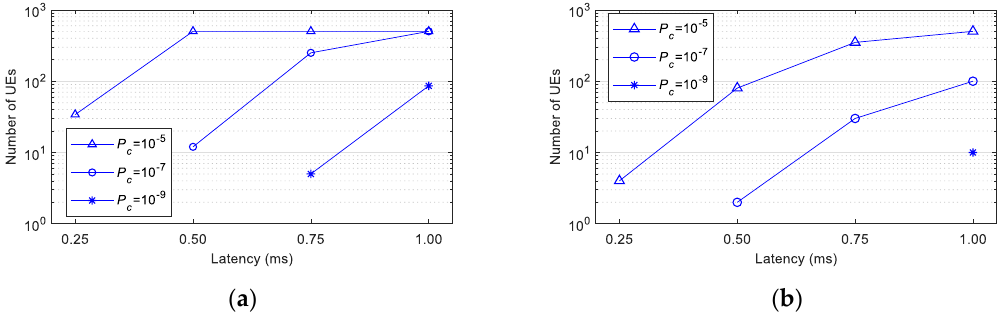
Figure 5. Number of UEs supported with different requirements ( L and P rel = 1 − P c , when P sc = 0): ( a ) λ = 0.1 packets; ( b ) λ = 1 packet.